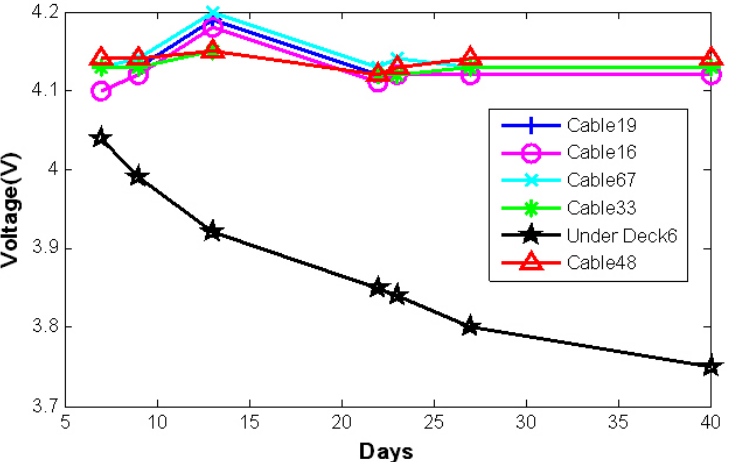
Figure 1. Charging status of the solar rechargeable batteries of the SHM system on the second Jindo Bridge [2].